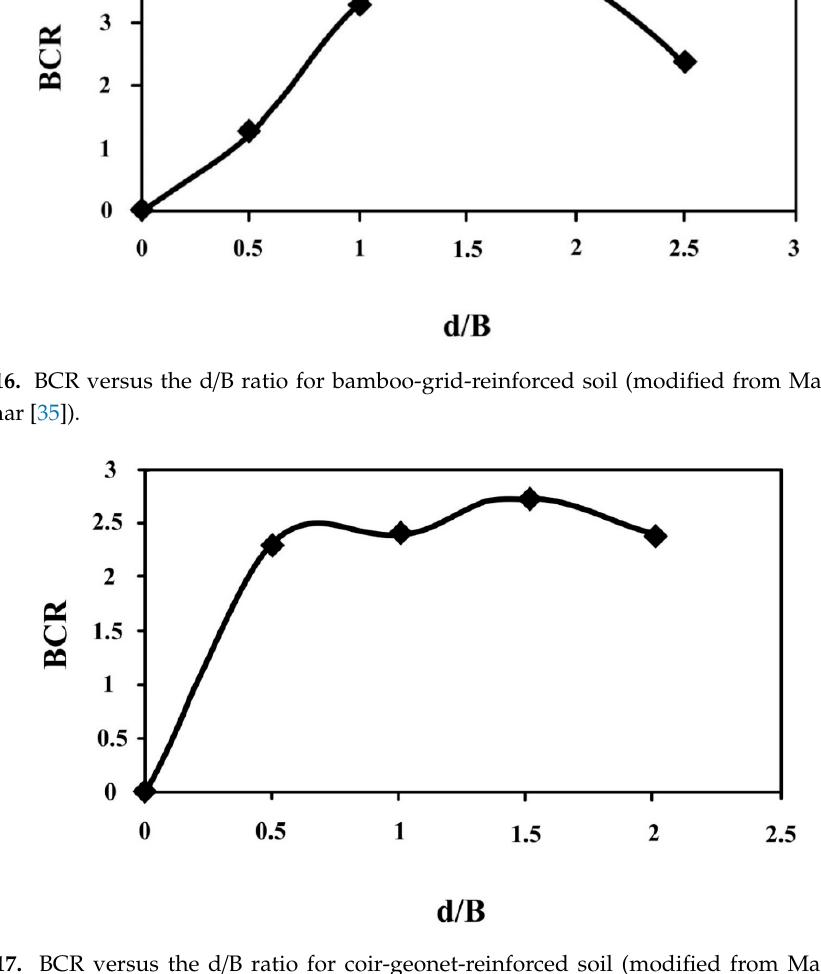
Figure 17. BCR versus the d / B ratio for coir-geonet-reinforced soil (modified from Mathew and Sasikumar [35]). Table 5. Typical and recommended parameters of the soft soil reinforcement